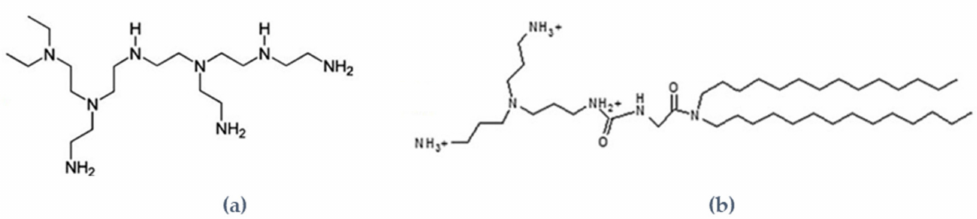
Figure 3. ( a ) Structure of polyethylenimine (branched) and ( b ) structure of dimyristoylaminopropylaminopropyl (DMAPAP)